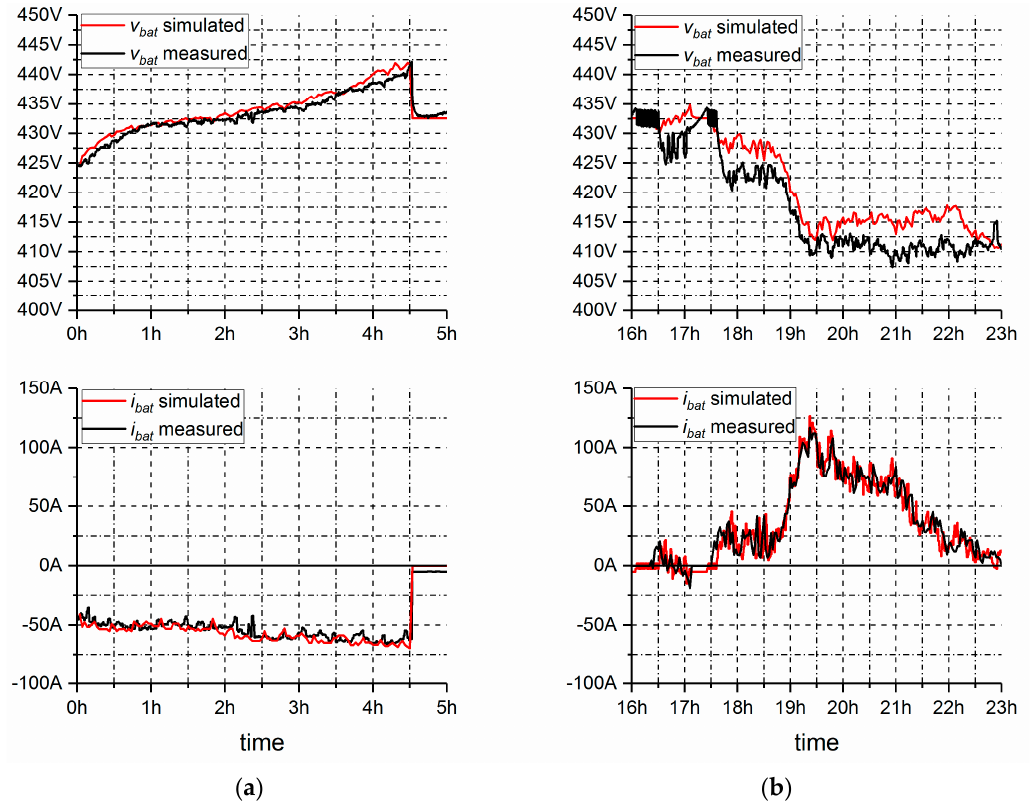
Figure 18. Simulation and measurement results for Thevenin-based model ( a ) charging and ( b ) discharge.